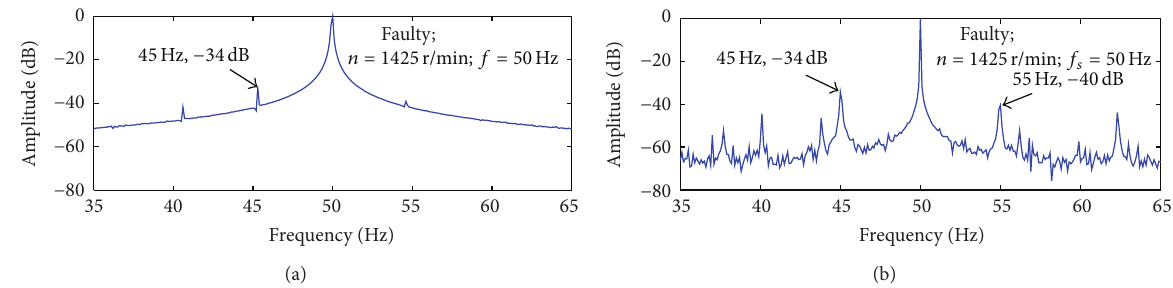
Figure 8: Power spectrum of the stator current around the fundamental component for (a) main-fed and (b) inverter-fed fault squirrel-cage